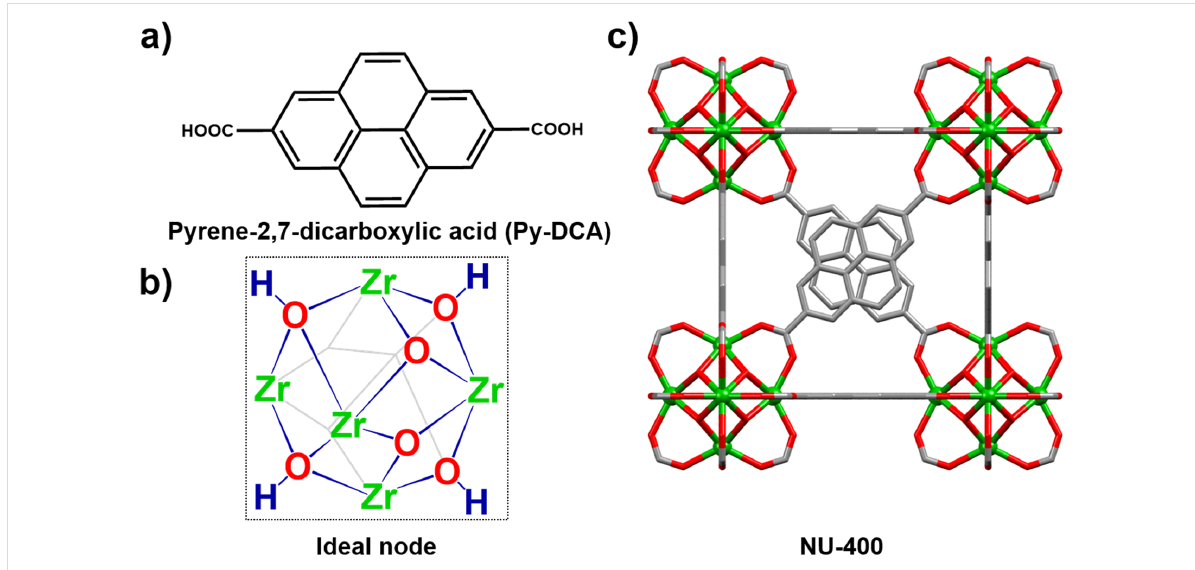
Figure 1: NU-400 constituents: a) the pyrene-based linker, pyrene-2,7-dicarboxylic acid and b) Zr 6 metal node. c) Fragment of the crystal structure of NU-400, established from PXRD data. Hydrogen atoms and disorder of pyrene groups are not shown for clarity. Zr: green, O: red, and C: grey.